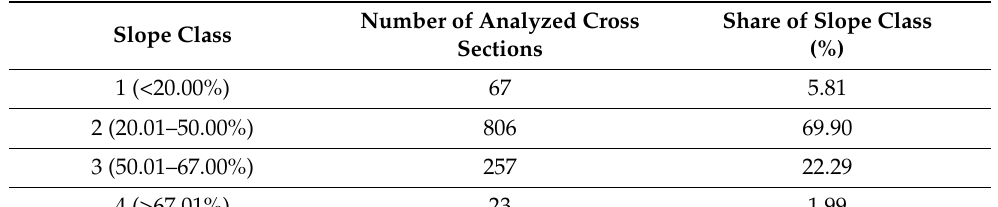
Table 3. Share of analyzed profiles by slope classes. Yellow highlighted text represents calculated values based on terrain survey data and the red bold text represent